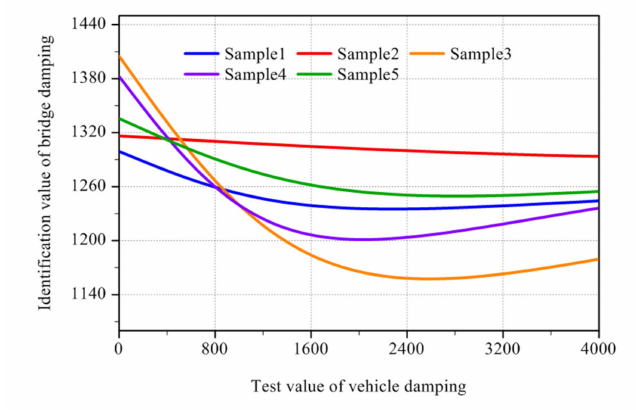
Figure 16. Bridge damping identification curve (12:00~12:59).